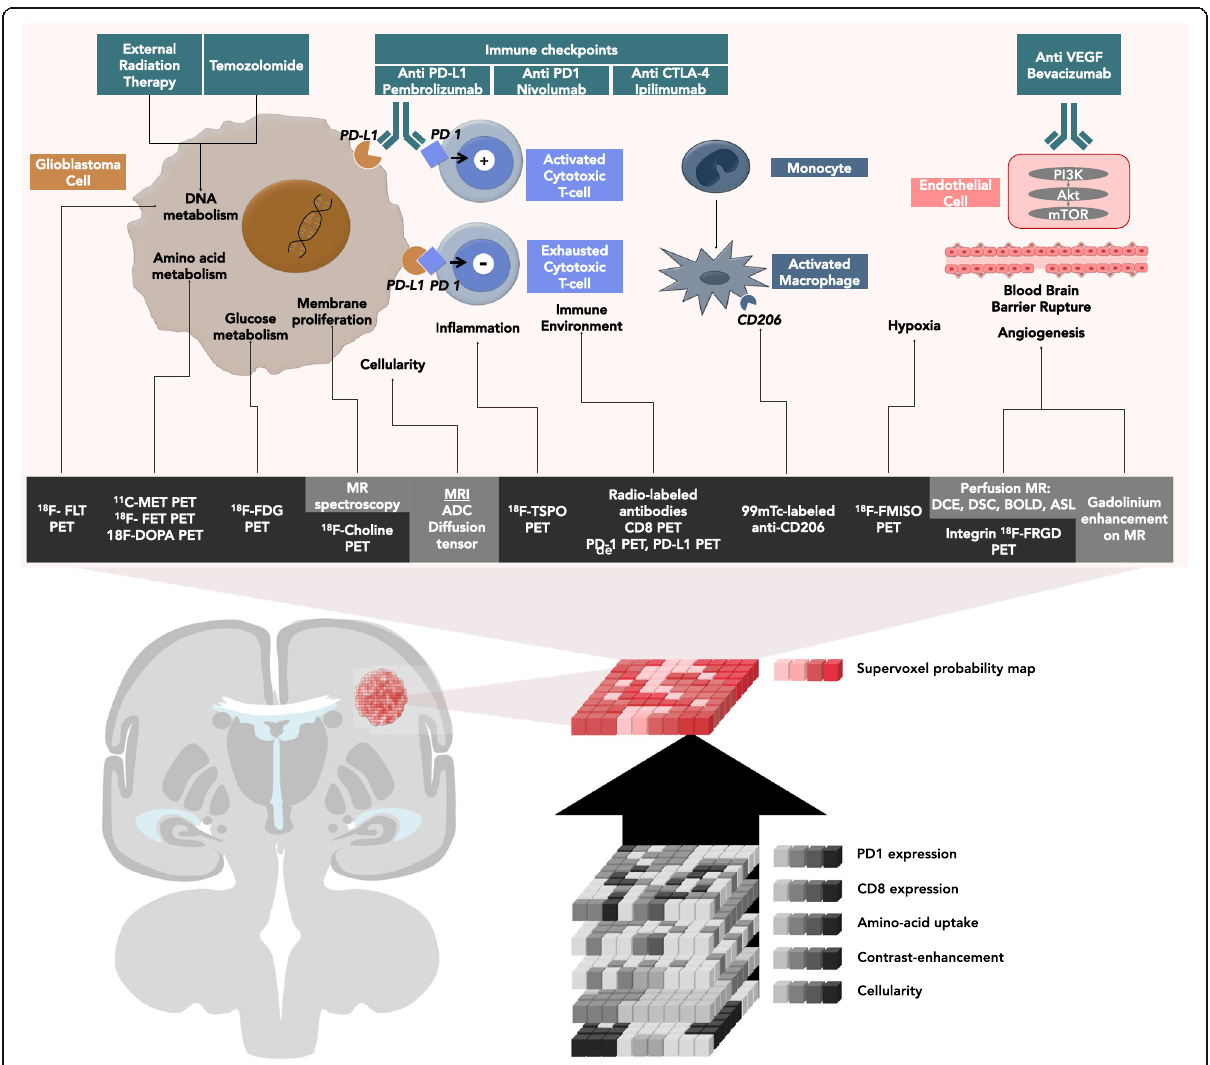
Fig. 1 Imaging of actionable molecular pathways in patients with glioblastoma: the concept of supervoxels. Imaging allows non-invasive evaluation of the action of immune checkpoint modulators in patients with glioblastoma. Currently, most clinicians perform a visual and qualitative assessment. Alternatively, artificial intelligence can be trained to extract imaging biomarkers by measuring the signal in each unique voxel of a region of interest provided by each imaging technique. Ultimately, artificial intelligence can resume the information provided by multiple voxels from multiple imaging modality to provide one single quantitative probability map using supervoxels (synthetic summary of all voxels from the same volume of interest using different imaging